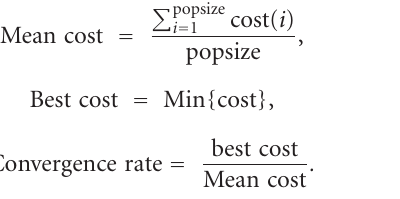
Figure 15: Analytic comparison of convergence ratio of BA, LFFA, and